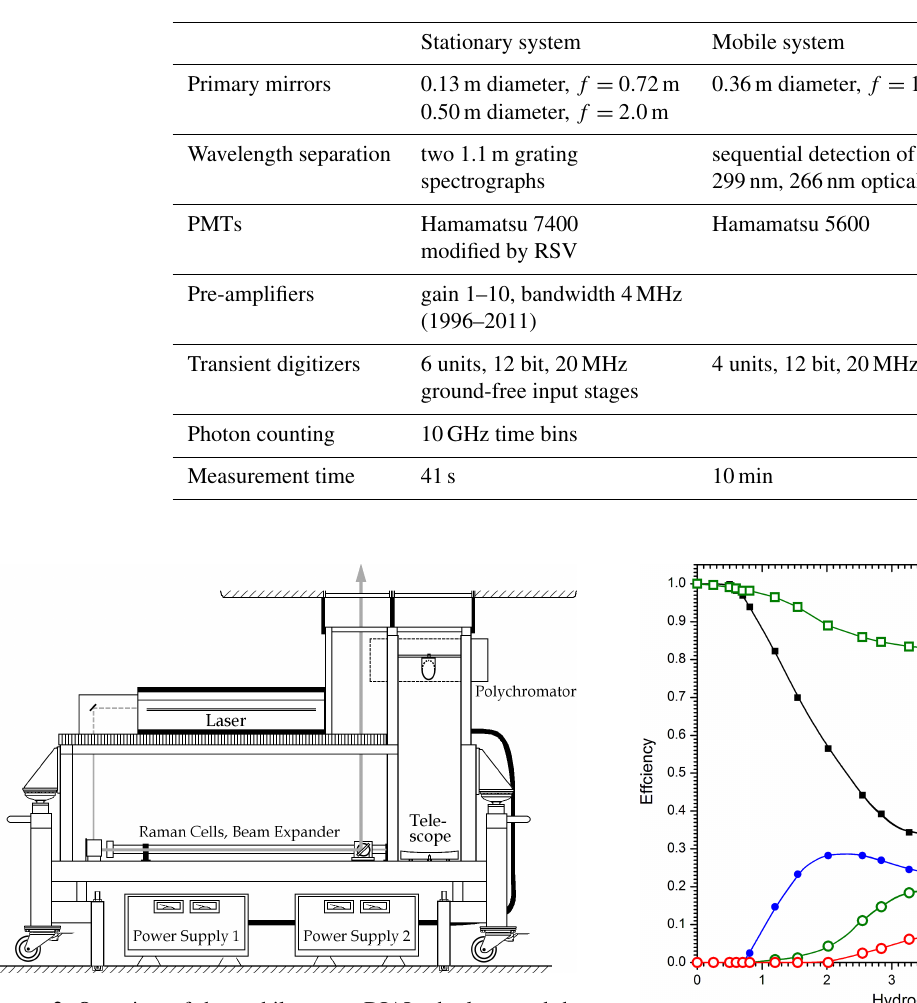
Table 2. Receiver details (latest version only).